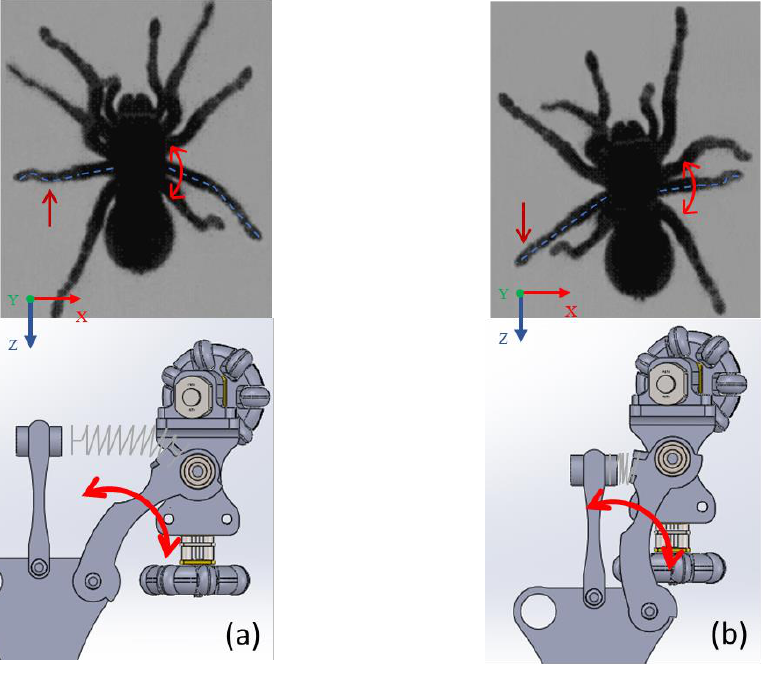
Figure 3. Movements of a spider and a robot design along x -axis direction ( a ) The robot leg imitating the spider leg’s movement when it is out of the pipe ( b ) the robot leg imitating the movement of the spider leg when it is inside the pipe.